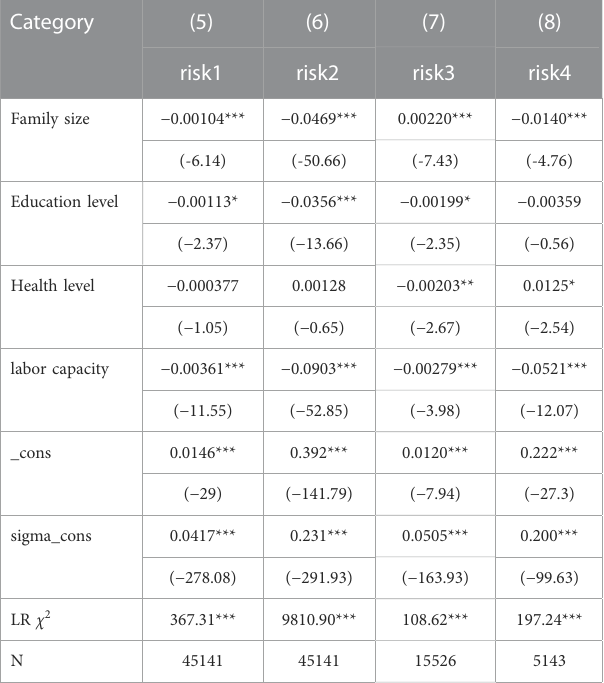
TABLE 5 Tobit regression estimates of human capital variables to re-poverty risk.